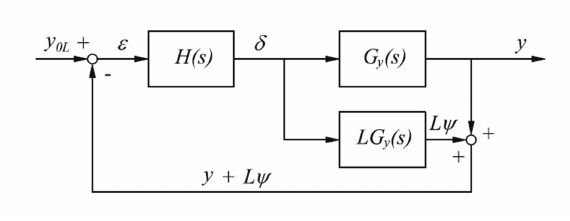
Fig. 3. The simple block diagram of a driver-vehicle system